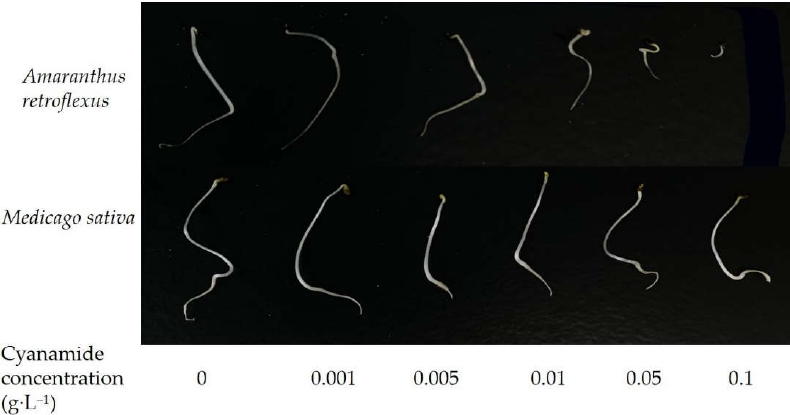
Figure 1. The effects of alfalfa and amaranth seeds treated with different concentrations of cyanamide for 7 days.